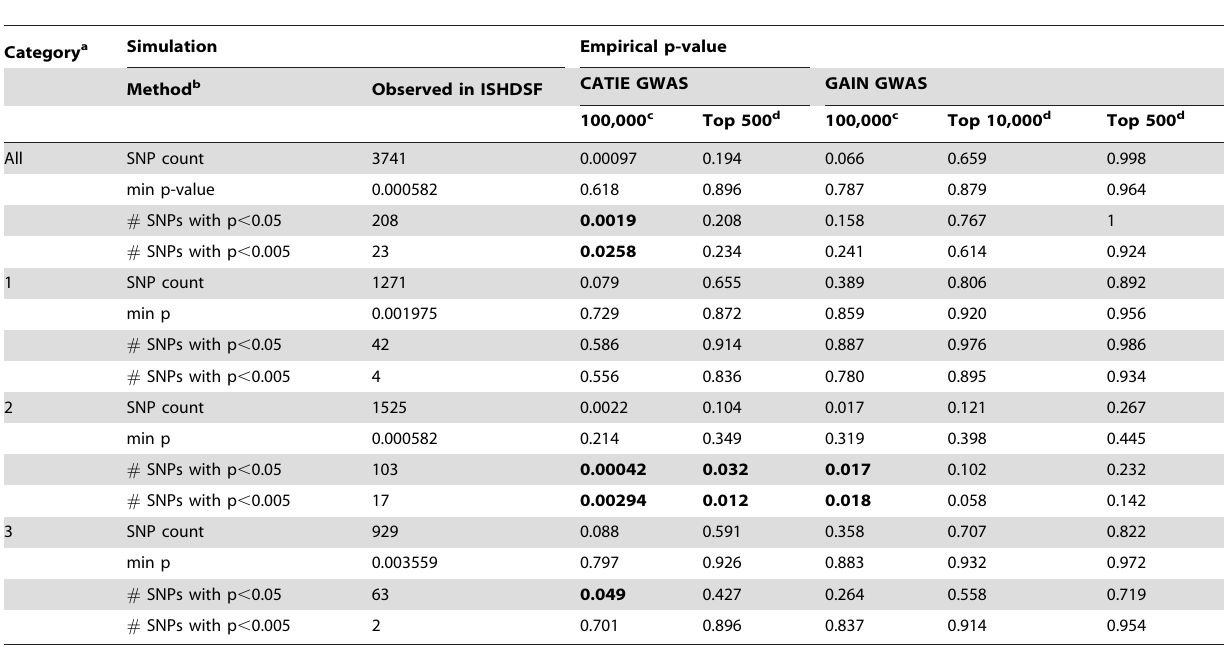
Table 3. Comparison of ISHDSF rank and hypothesis based gene selection results to random gene selection in schizophrenia CATIE and GAIN GWAS datasets.